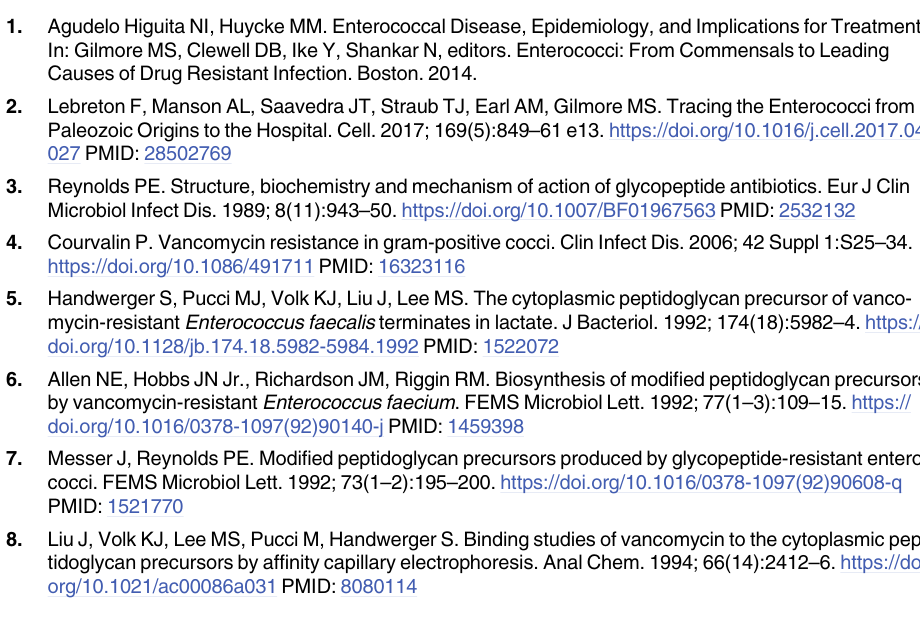
value < 0.05. Stars indicate significant differences between vancomycin- and H-CHG-treated cultures. S3 Fig. Quantification of intracellular organic phosphate (Pi) levels in E. faecium 1,231,410 wild-type and SE101 synergy escaper mutant. Intracellular Pi levels were mea- sured for both strains at different growth time points (OD 0.4–1.0) as described in materials 600 and methods. The levels (pmoles) were normalized using CFU count. Standard deviation was calculated from n = 5 independent experiments and significance value was calculated using